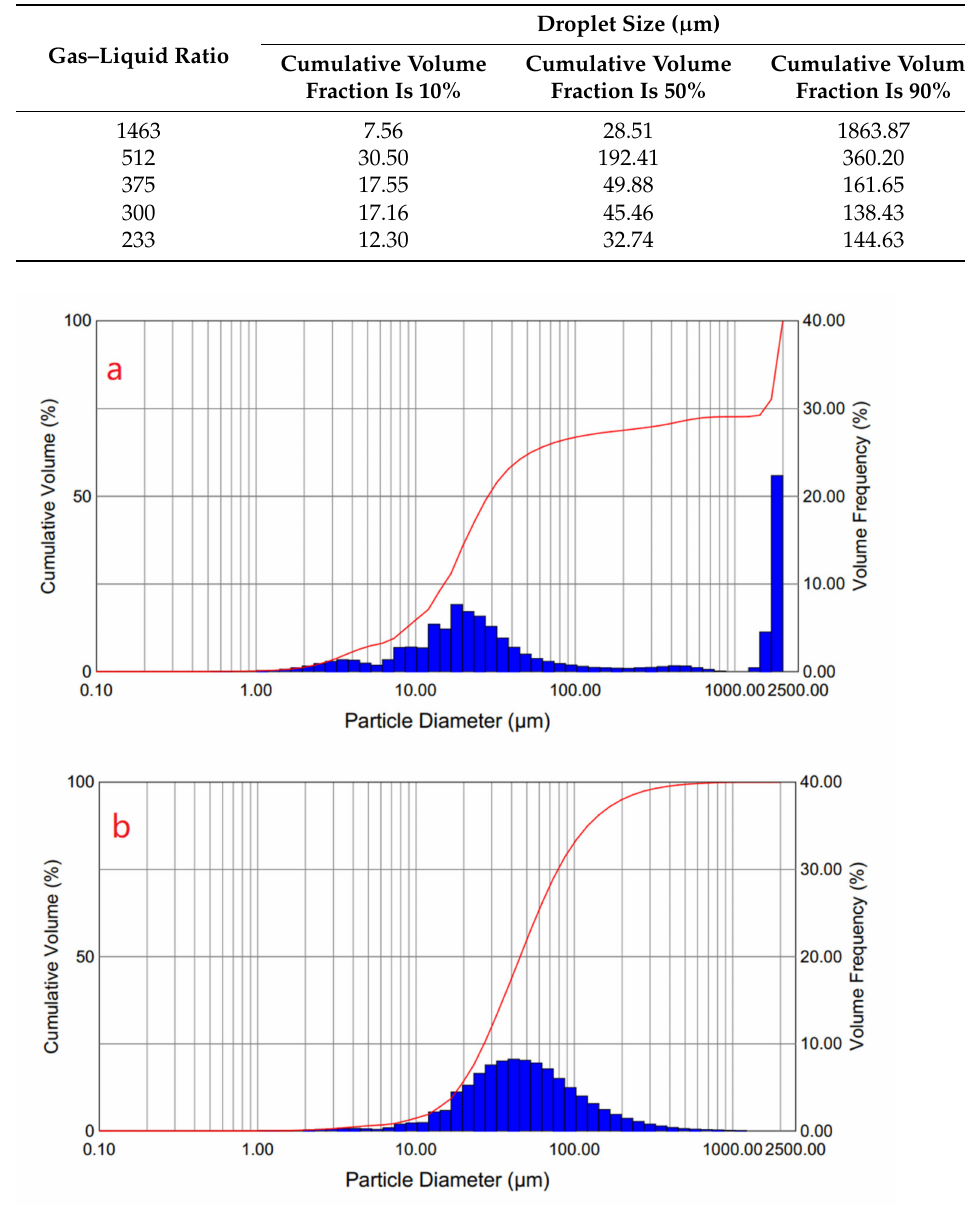
Figure 8. Droplet size distribution: ( a ) gas–liquid ratio is 1463 and ( b ) gas–liquid ratio is